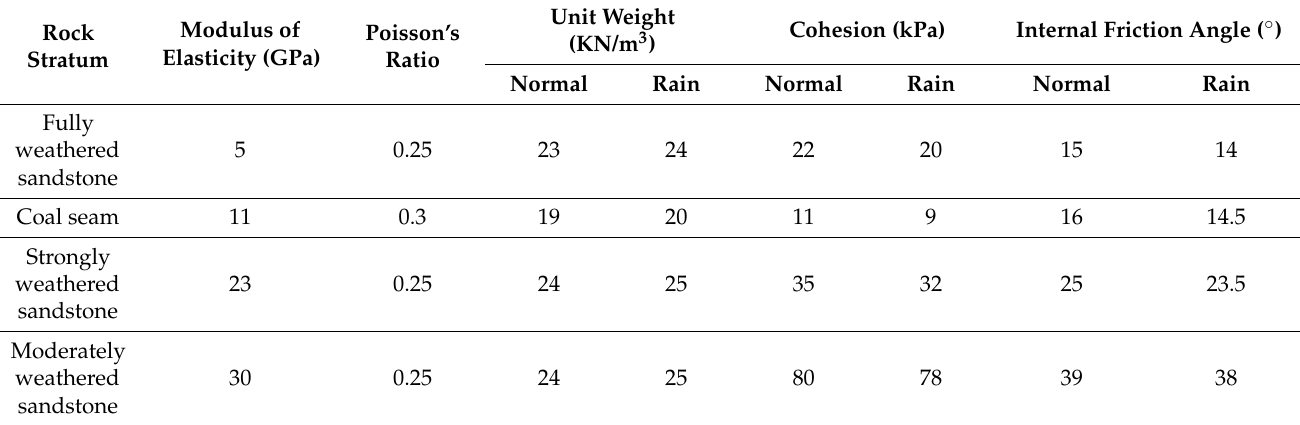
Table 1. Rock mechanics parameters of the